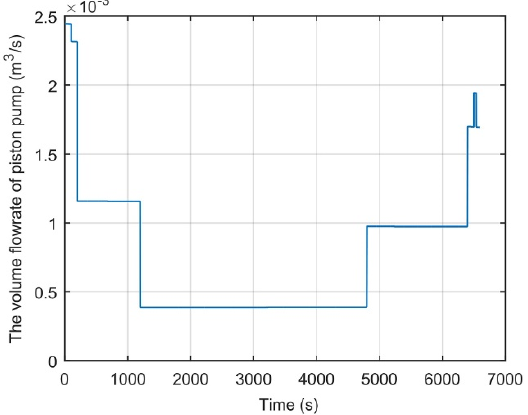
Figure 10. The volume flowrate of piston pump.